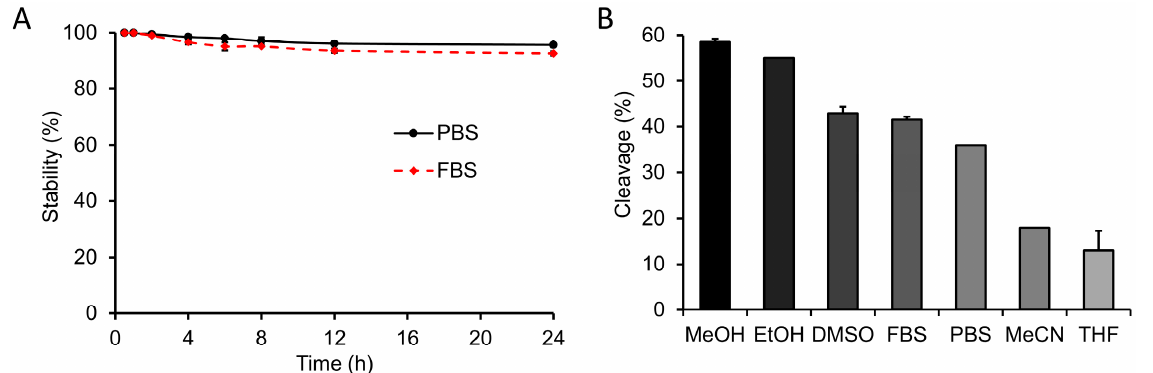
Figure 4. In vitro stability of [ 131 I]-DPTA-trastuzumab in PBS and FBS up to 24 h (n = 2) ( A ). Solvent effect on Staudinger ligation (n = 2) ( B ).